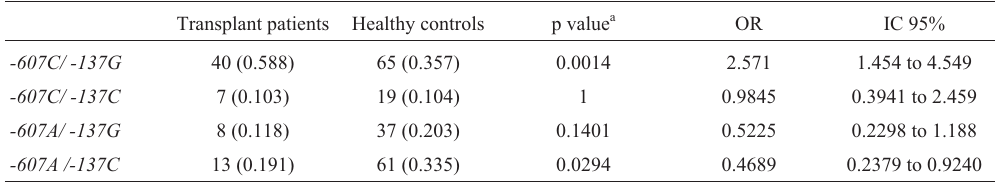
Table 4 - Haplotype frequencies (%) of IL18 promoter in healthy controls and kidney transplant patients. Transplant patients Healthy